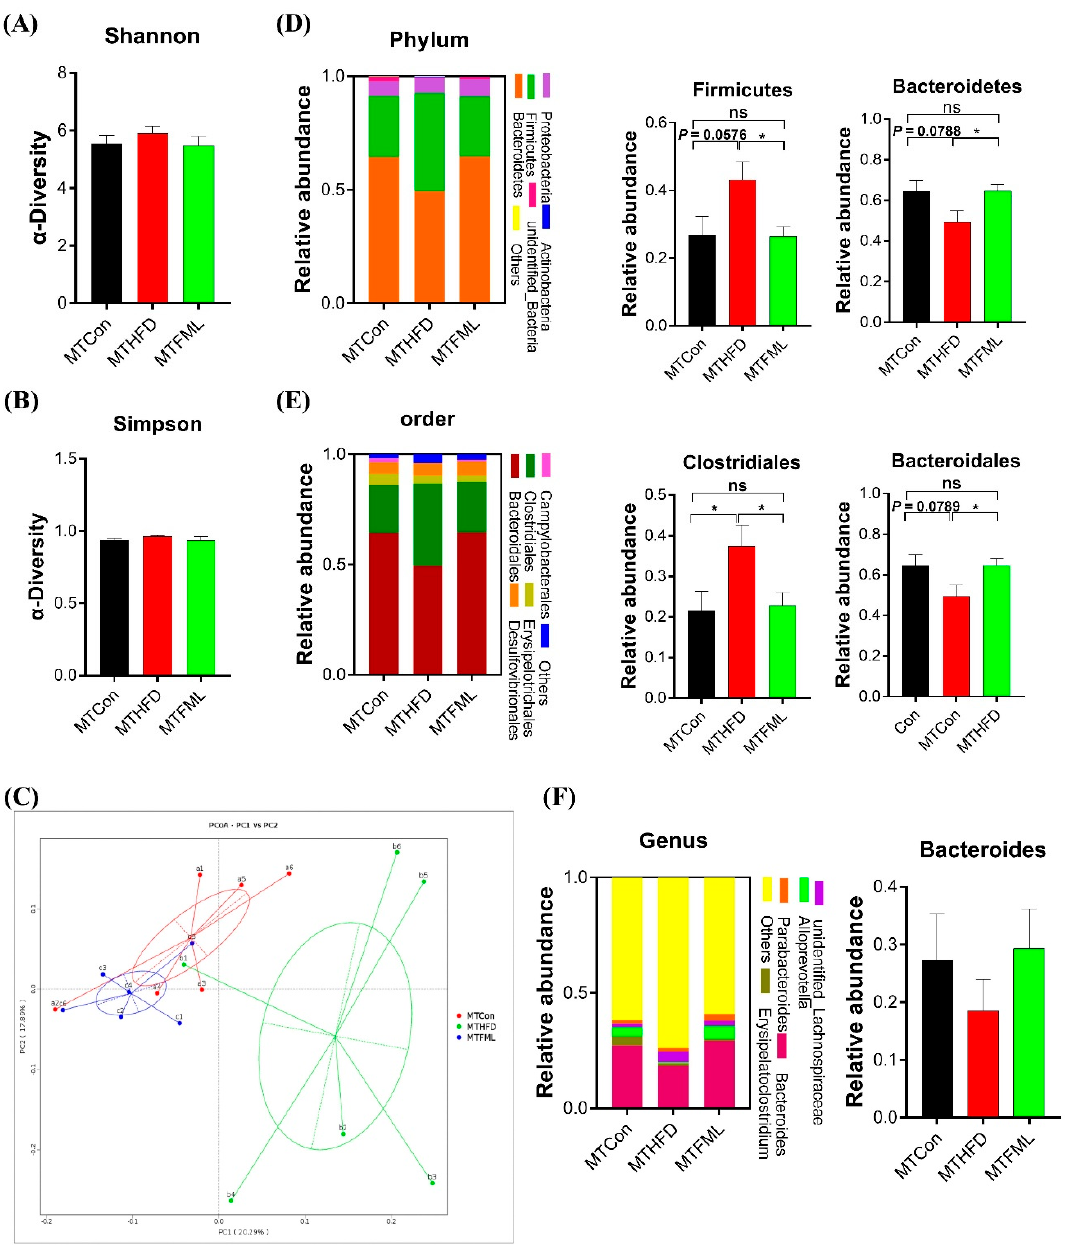
Figure 7. Gut microbiota in response to microbiota transplantation from Con (MTCon), HFD (MTHFD), and FML (MTFML) groups ( n = 6). ( A , B ) Indexes of Shannon and Simpson in α -diversity analysis, ( C ) PCoA plot analysis from each sample, ( D ) microbiota compositions at the phylum level, ( E ) microbiota compositions at the order level, and ( F ) microbiota compositions at the genus level. Data are presented as mean ± SEM, differences were denoted as follows: * p < 0.05, ns p > 0.05.